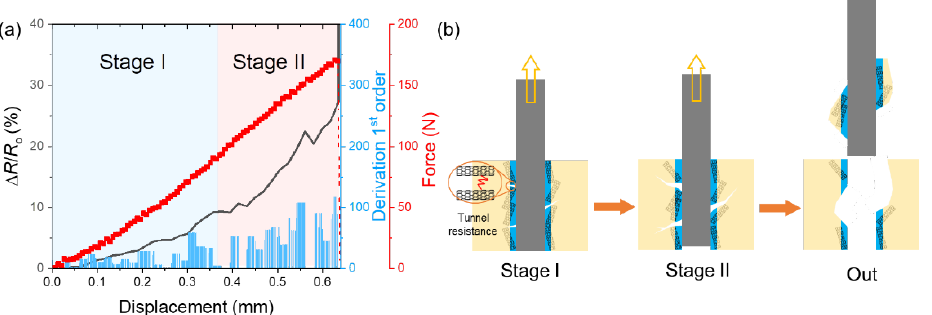
Figure 6. ( a ) The resistance increment ratio, black line, ( ∆ R/R o , ∆ R = |R o − R| is the resistance change compared to its initial value R o .) as a function of displacement is shown on the left axis, while its 1st-order derivation (blue column) is shown on the right axis. The corresponding load–displacement curve (red line) on the right axis is shown for comparison. The pull-out process is identified as having two stages, the schematic of which is shown in ( b ).